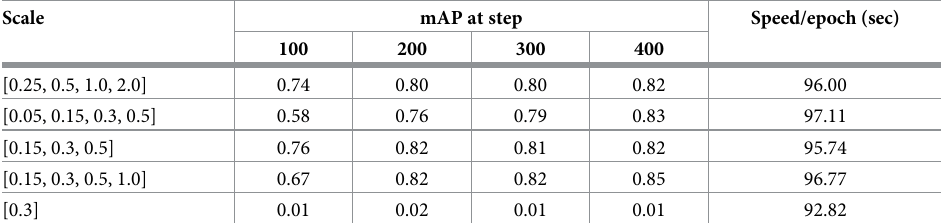
mAP performance comparison of the models trained using five scales at the anchor generator. This performance was evaluated at 100, 200, 300, and 400 steps, and the training time per epoch is shown in seconds for each configuration. The scales were adjusted so that the cells’ dimensions were taken into account.